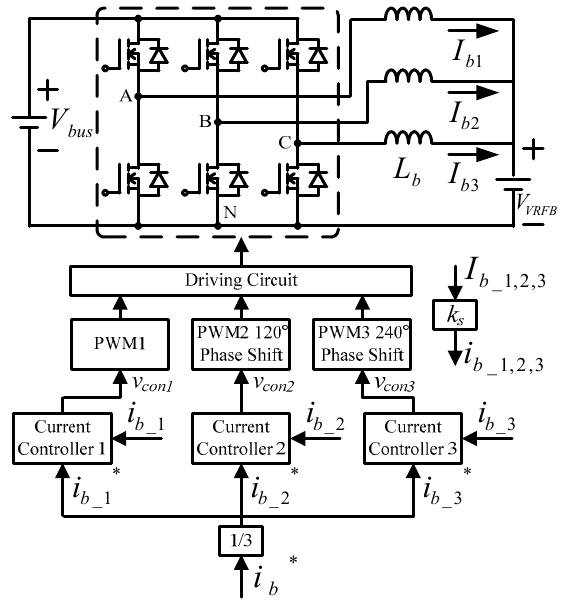
Figure 12. Overall control architecture of interleaved buck-boost converter (* indicates commands).